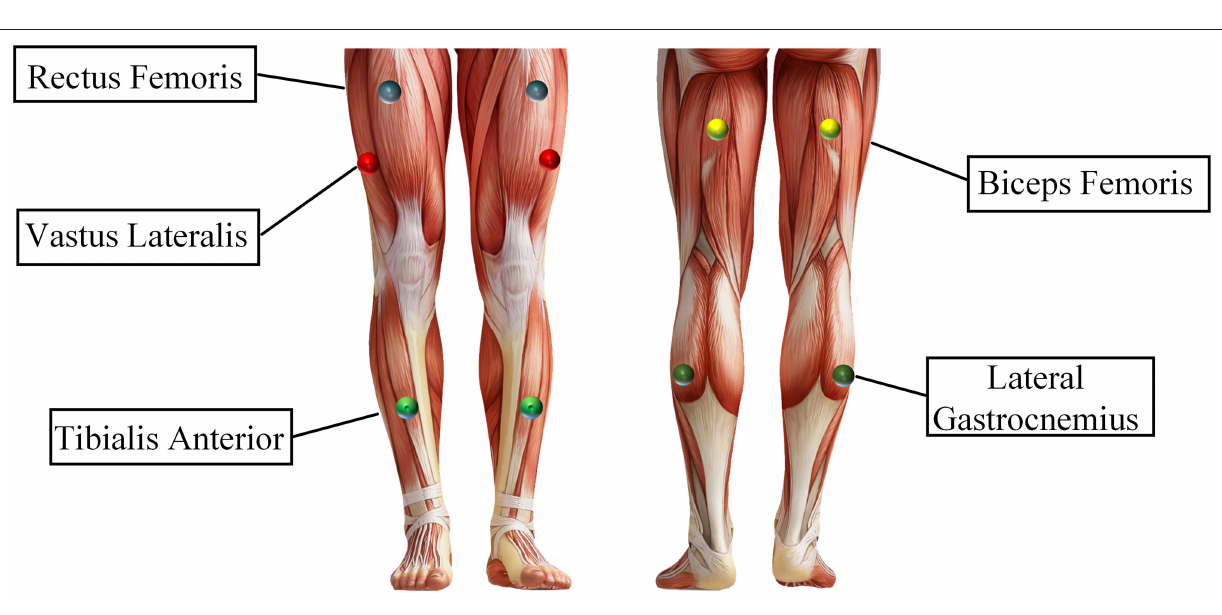
FIGURE 3 | The lower limb muscle used in the sEMG data acquisition